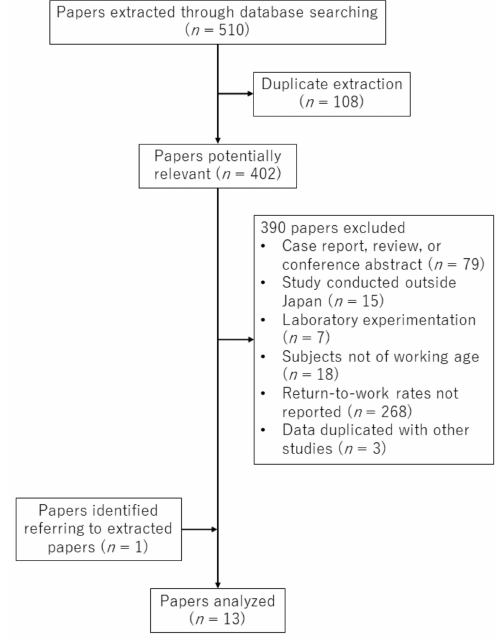
Figure 1. Paper selection